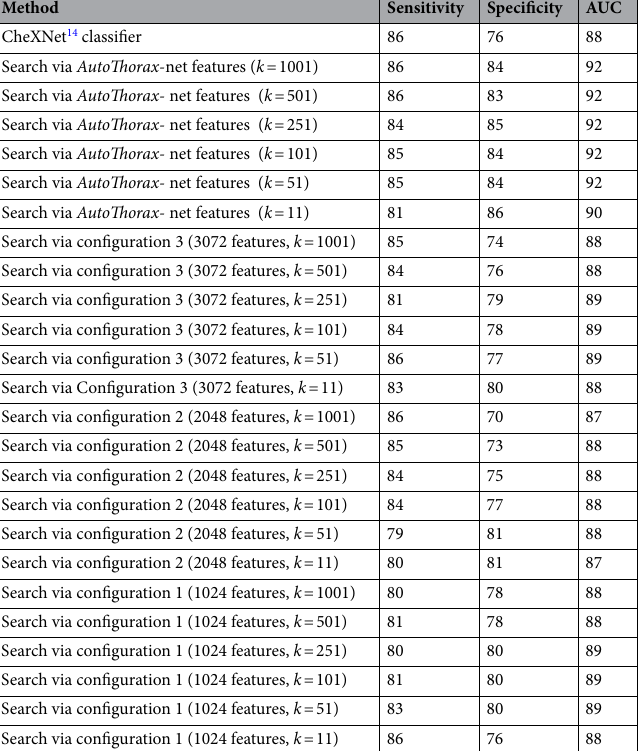
Table 3. A summary of classification performance using image search as a classifier on Dataset 1. The numbers (in percentage) are the result of averaging 10 folds with very low standard deviation (< 1%).